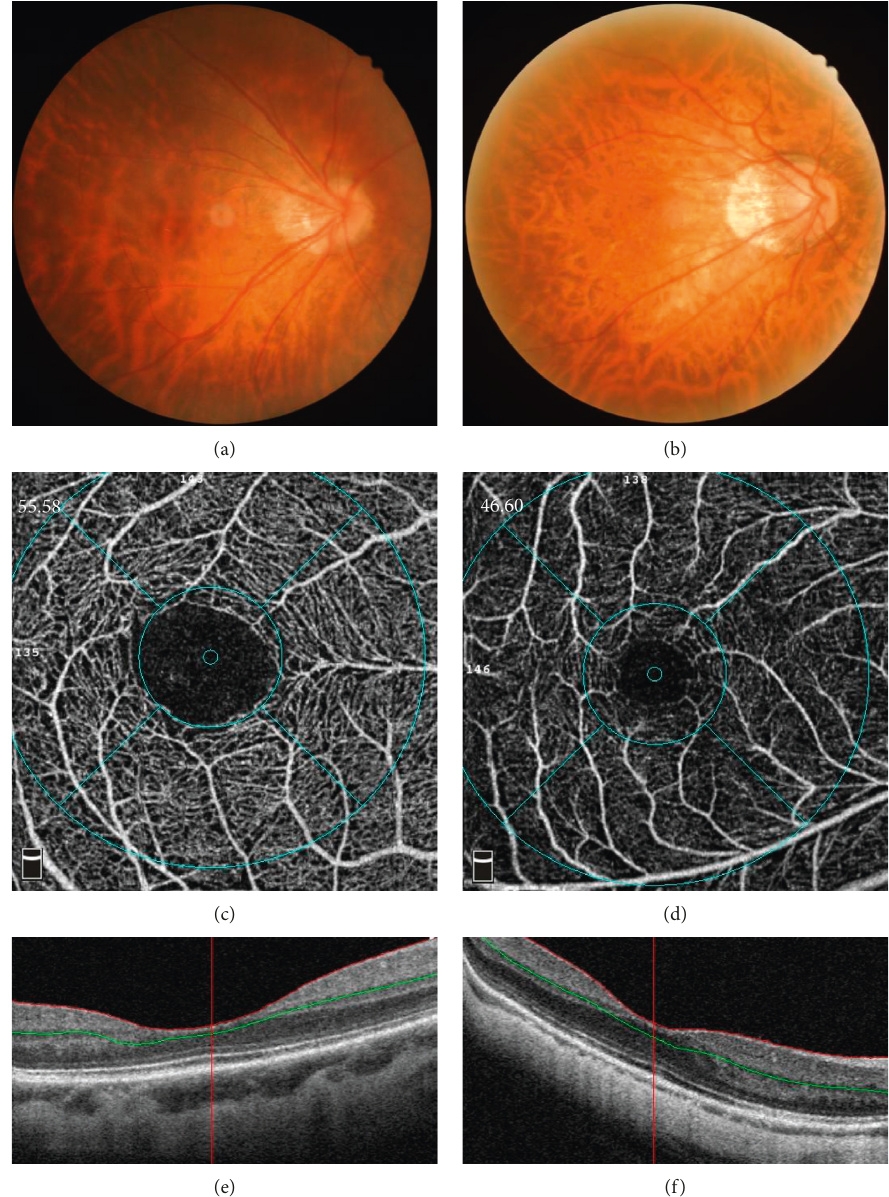
Figure 1: Representative images of eyes with early dry-type myopic maculopathy. A 37-year-old female patient with tessellated fundus (a), superficial vessel density of 52.05 (c), and thick choroid (e). A 40-year-old female patient with diffuse chorioretinal atrophy (b), superficial vessel density of 46.60 (d), and a thinner choroid than in the left